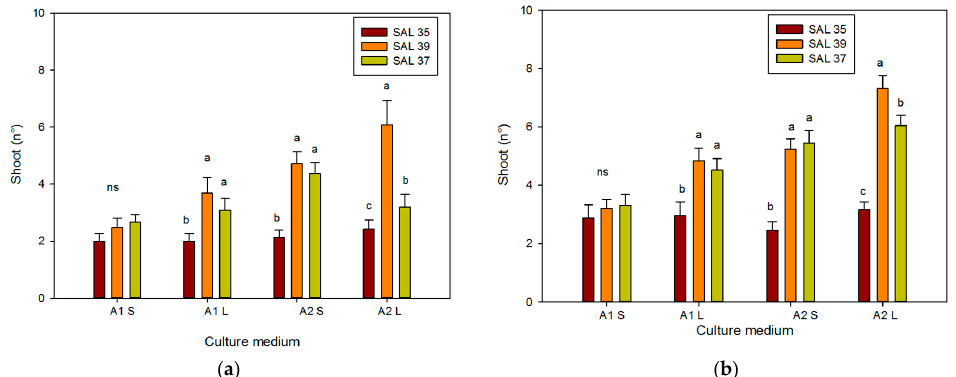
Figure 6. Effect of different culture systems and plant growth regulator (PGR) concentrations on the number of shoots in different C. spinosa accessions after 30 ( a ) and 60 days ( b ). Bars represent standard error. The different letters reported above the bars grouped for each single treatment indicate statistically significant differences; n.s. not significant (Tukey’s test, p ≤ 0.05 ).